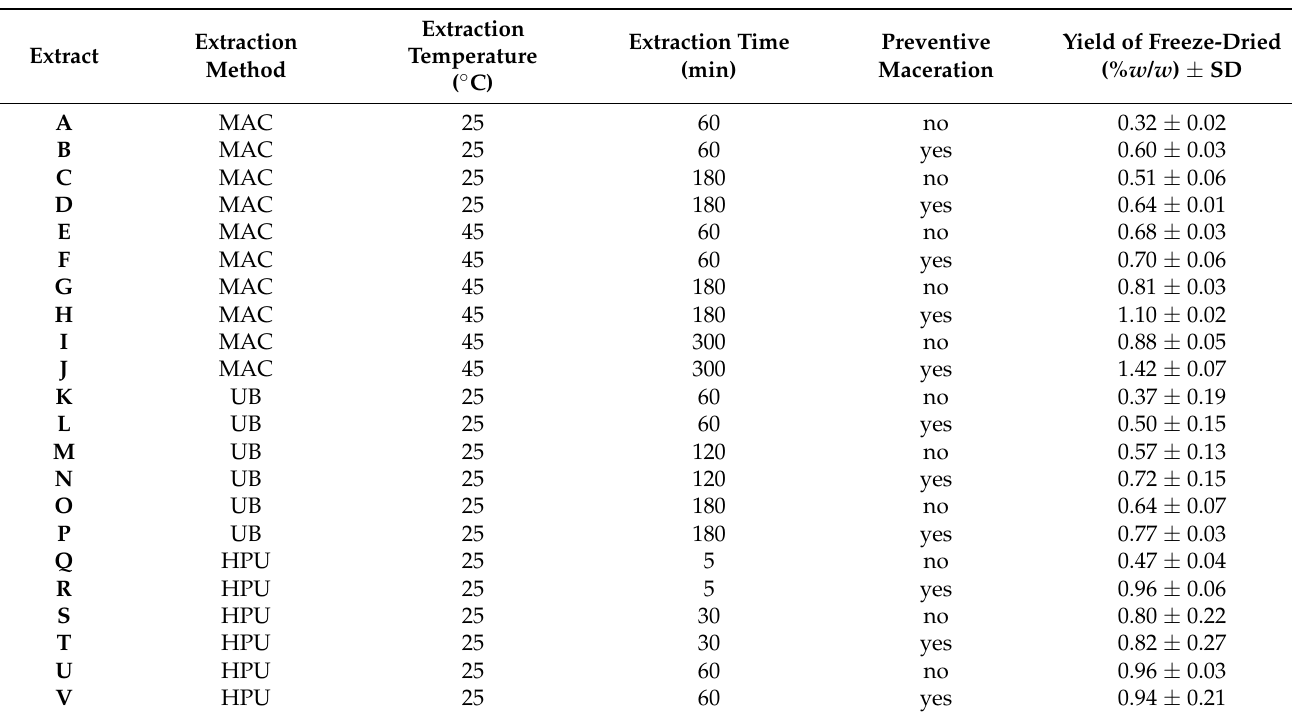
Table 2. Extraction conditions and